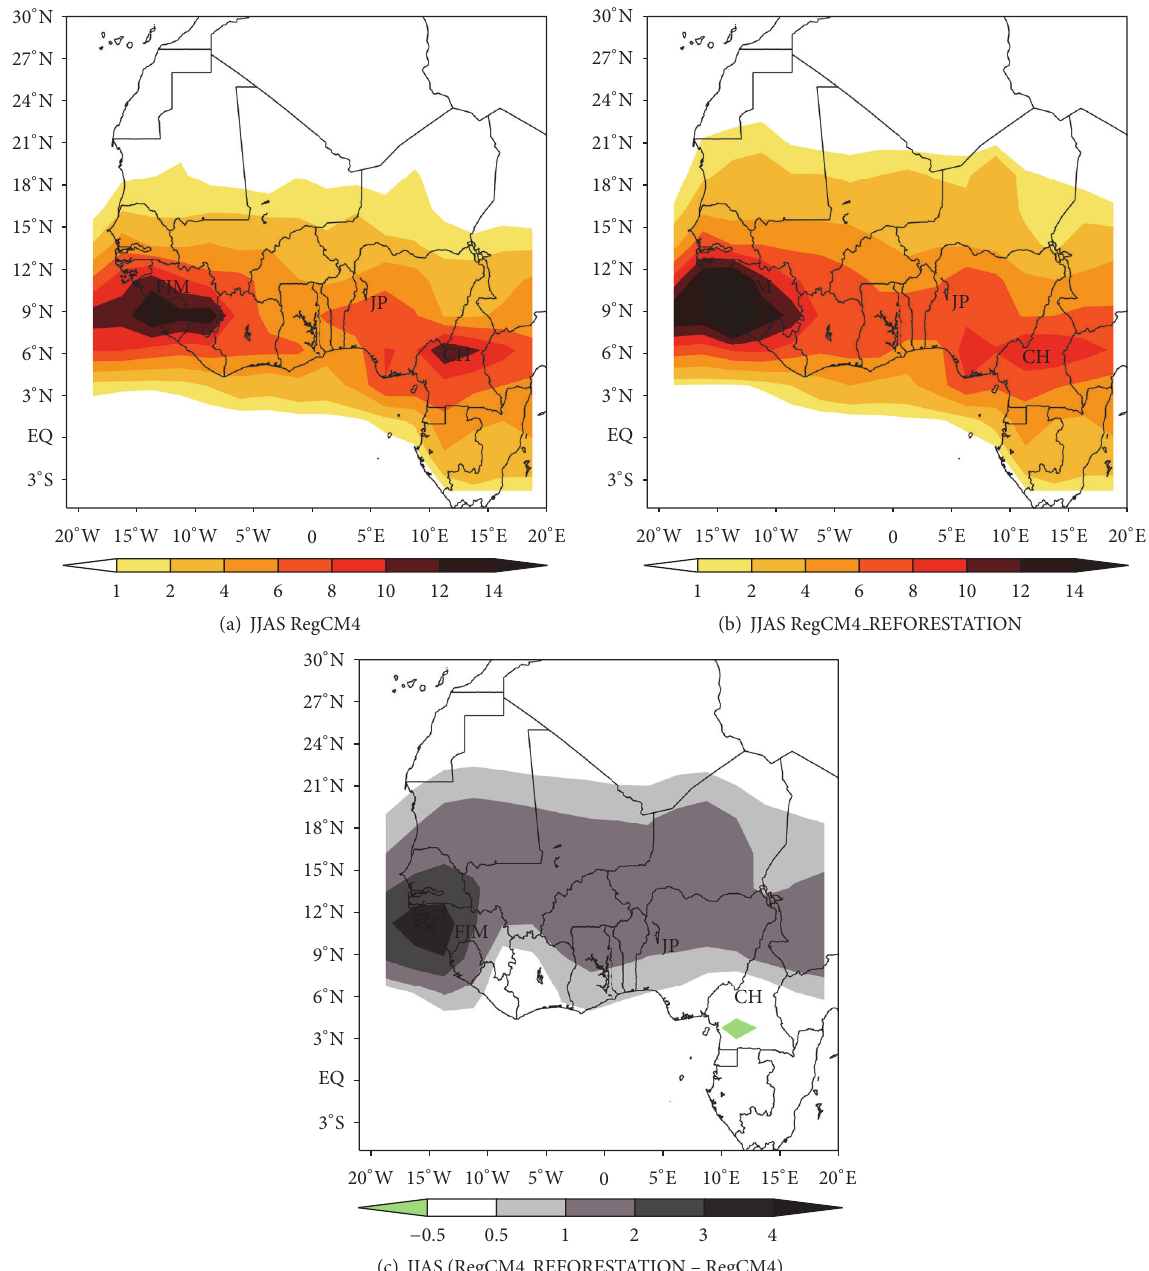
Figure 4: Mean summer rainfall (mm/day) averaged from 2003 to 2009 over West Africa: (a) RegCM4, (b) RegCM4 REFORESTATION, and (c) difference between RegCM4 REFORESTATION and